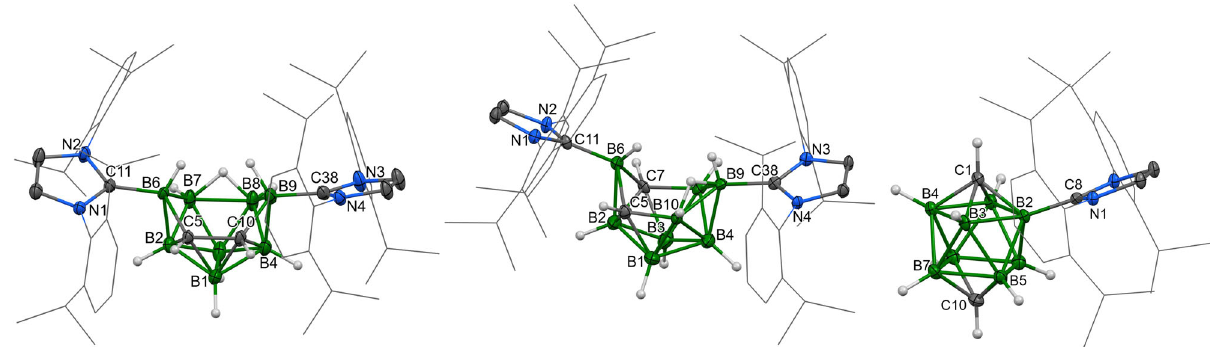
Fig. 3 The molecular structures of o -2a (left), m -2a (centre) and p -2a (right). ORTEP-type plots, 40% probability level. Cl − or HCl 2 − anions and dichlormethane solvates are omitted for clarity. The 2,6-diisopropylphenyl groups are displayed as wireframes for